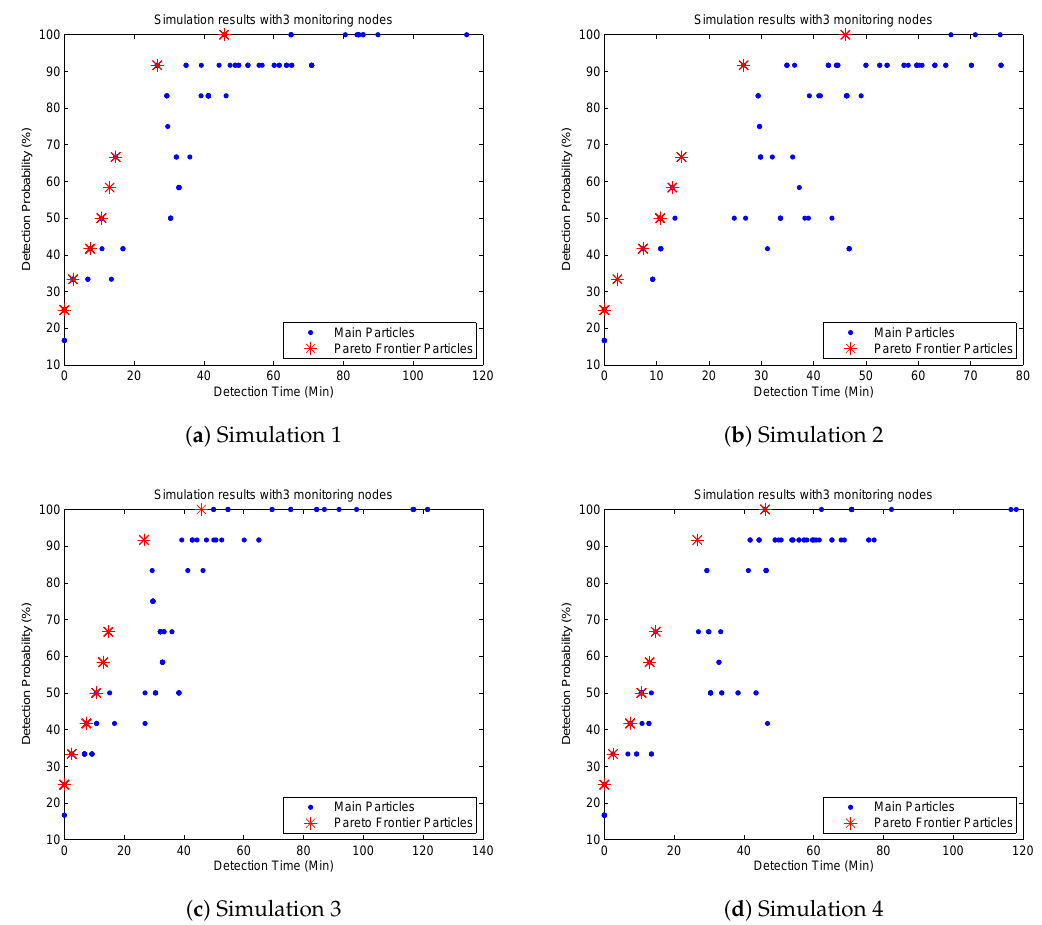
Figure 4. Pareto frontier with three monitoring nodes and a detection threshold of 0.01